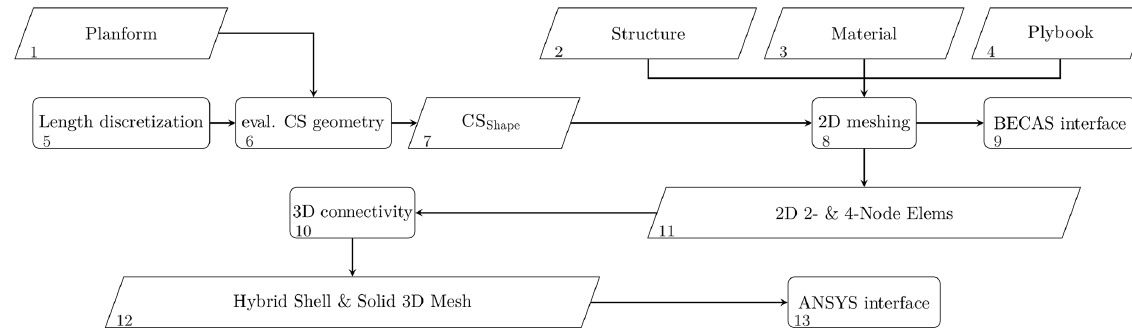
length c ∗ calculated via the respective spline (11, 17), shifted along the chord to the correct threading point by the coordi- nate tp ∗ (12, 18), and twisted by the twist angle θ ∗ (13,